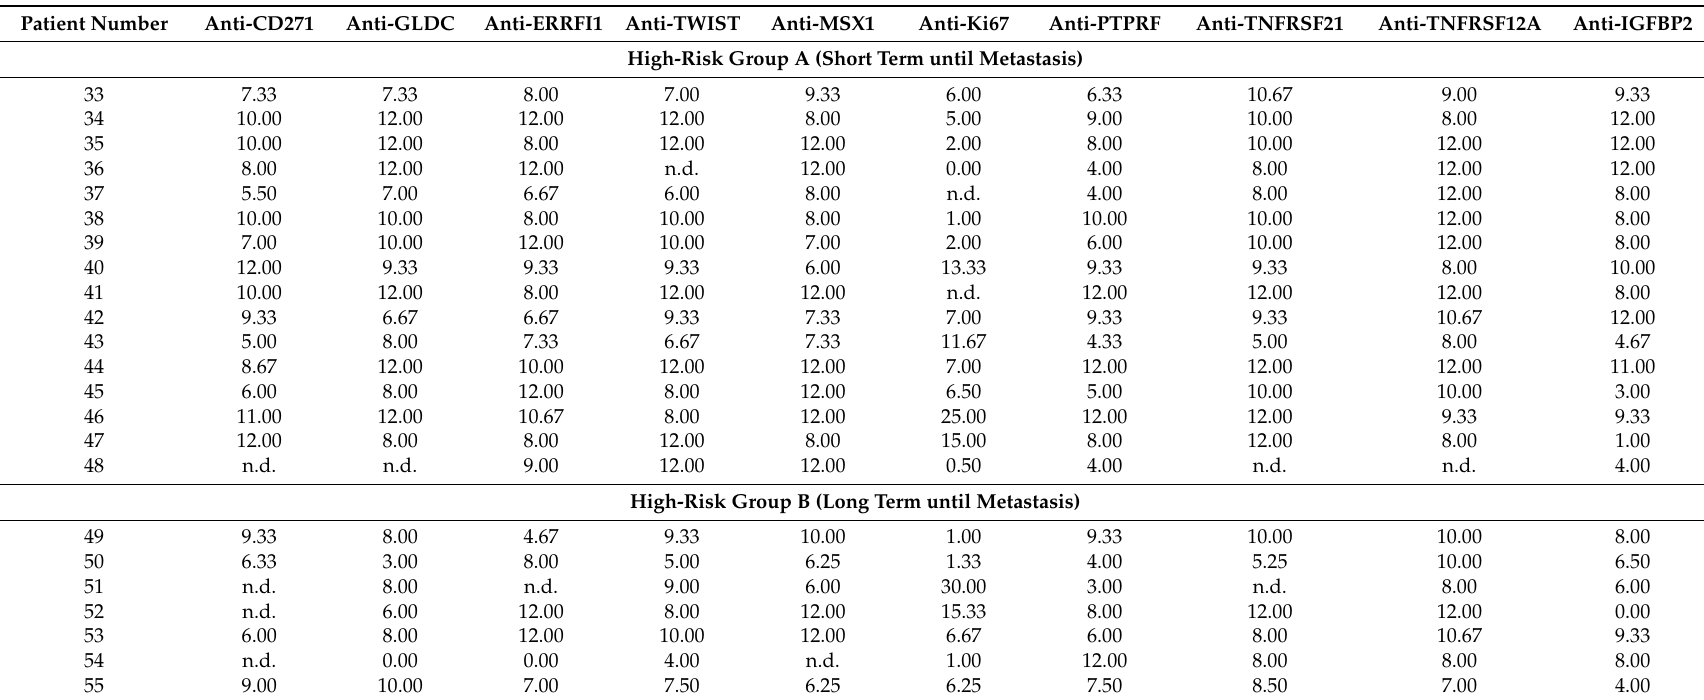
Table 3. IHC scores for each antibody (high-risk